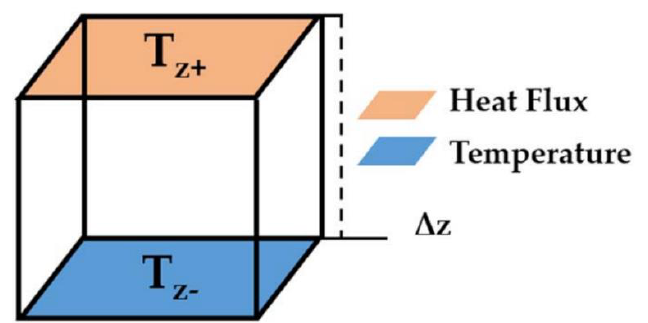
Figure 3. Constant heat flux and constant temperature were set on the two opposite faces of RVE [30].